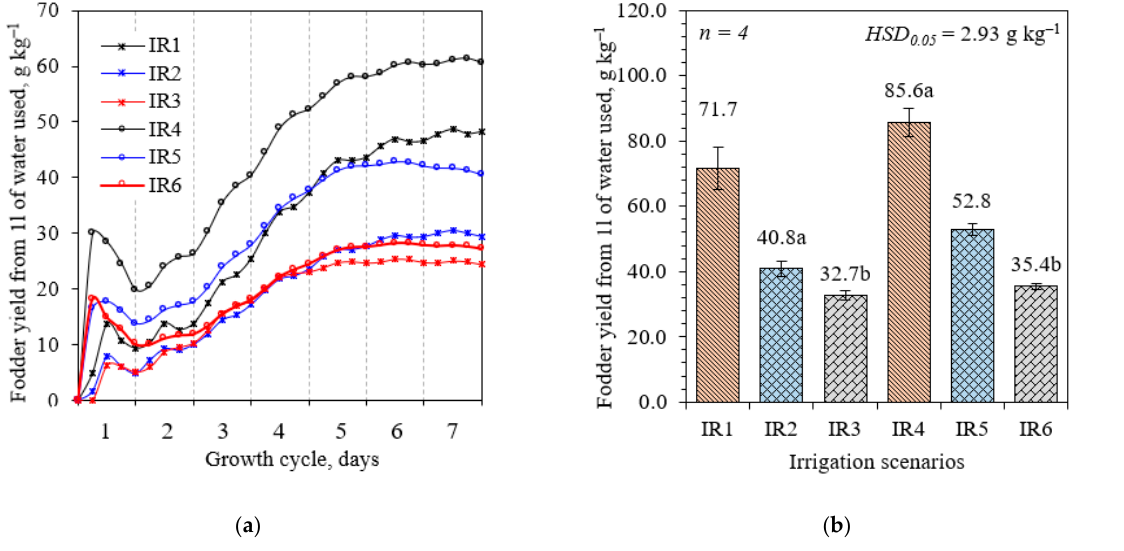
Figure 8. ( a ) Dynamics of wheat fodder yields from 1 L of water used during a 7 ‐ day growth cycle under different irrigation scenarios. Four repetitions n were performed in each scenario. ( b ) Wheat fodder yields from 1 L of water used after a 7 ‐ day growth cycle under different irrigation scenarios. Four repetitions n were performed in each scenario. Any two samples with a common letter are not significantly different ( p > 0.05), as assessed using honestly significant difference.